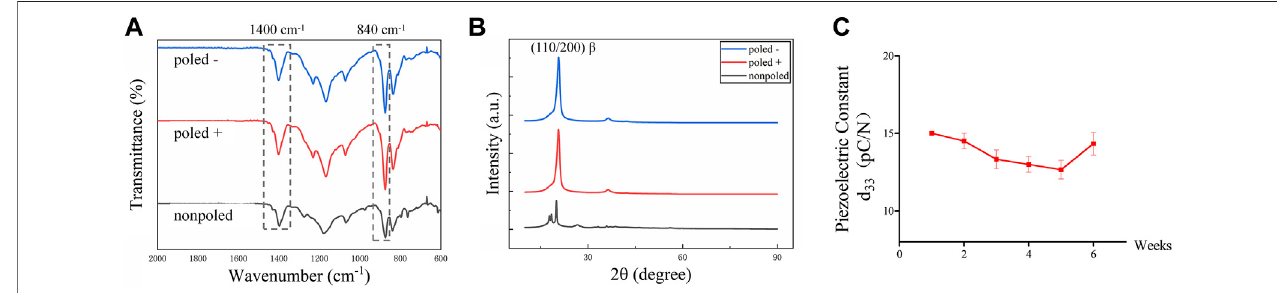
FIGURE2| PiezoelectriccharacterizationofP(VDF-TrFE)membranes. (A) FTIRimagesand (B) XRDpatternsfor “ poled − , ”“ poled+ ” and “ nonpoled ” P(VDF-TrFE) samples, demonstrating the content of electroactive β -phase. (C) Piezoelectric coef fi cient (d33) of the poled P (VDF-TrFE) membranes immersed in DMEM for 6 weeks, indicating the stable electrical properties.